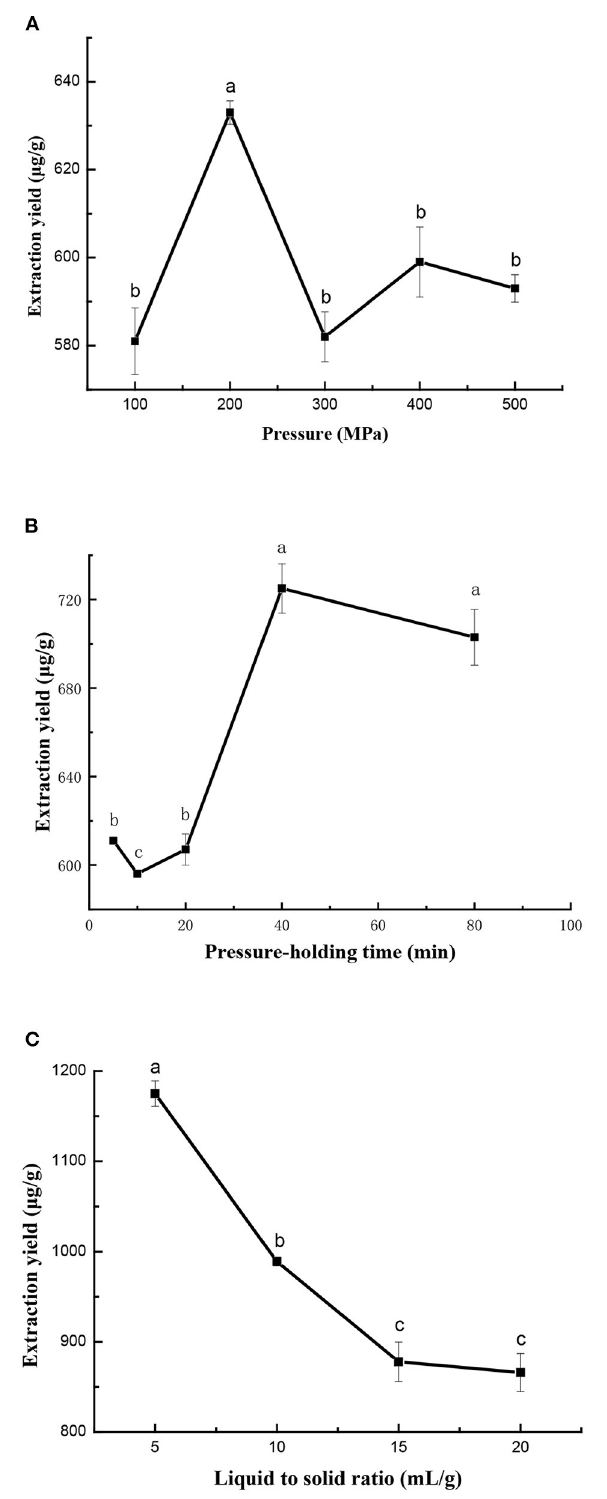
FIGURE 2 | Effect of extraction pressure (A) , pressure-holding time (B) , and ratio of liquid-to-solid (C) on ultra-high pressure extraction (UHPE) yield of cAMP from jujube. (A) Pressure-holding time: 10min; ratio of liquid-to-solid: 15 ml/g. (B) Extraction pressure: 200 MPa; ratio of liquid-to-solid: 15 ml/g. (C) Extraction pressure: 200 MPa; pressure-holding time: